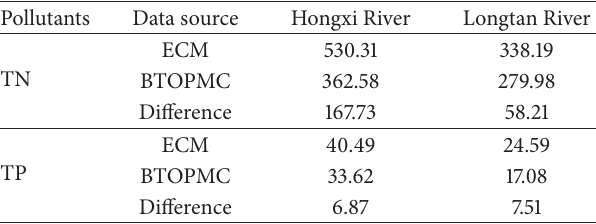
Table 5: The comparison of loads in TP and TN between the ECM and BTOPMC model (unit: